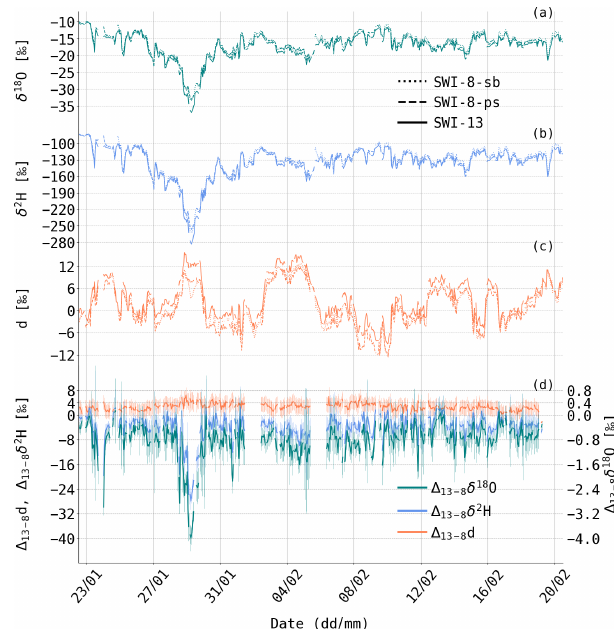
Figure 3. Time series of hourly means of (a) δ 18 O, (b) δ 2 H, (c) d and (d) (cid:49) 13 − 8 for leg 2 from SWI-13, SWI-8-ps and SWI-8-sb measurements. (cid:49) 13 − 8 is the difference between SWI-13 and SWI- 8-ps. The error bars in panel (d) denote hourly standard deviations of the 1s